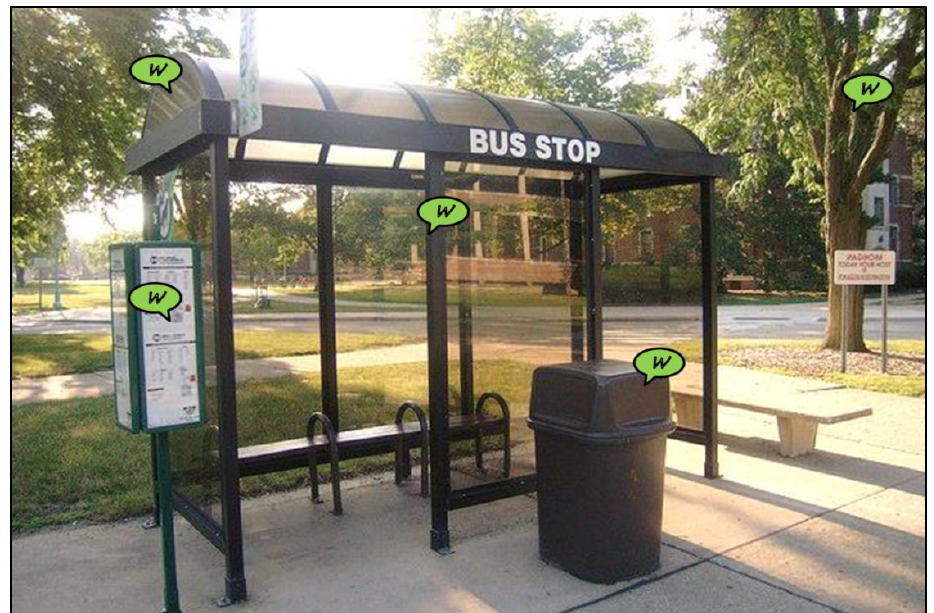
Figure 11. A bus stop equipped with SCM-WuR